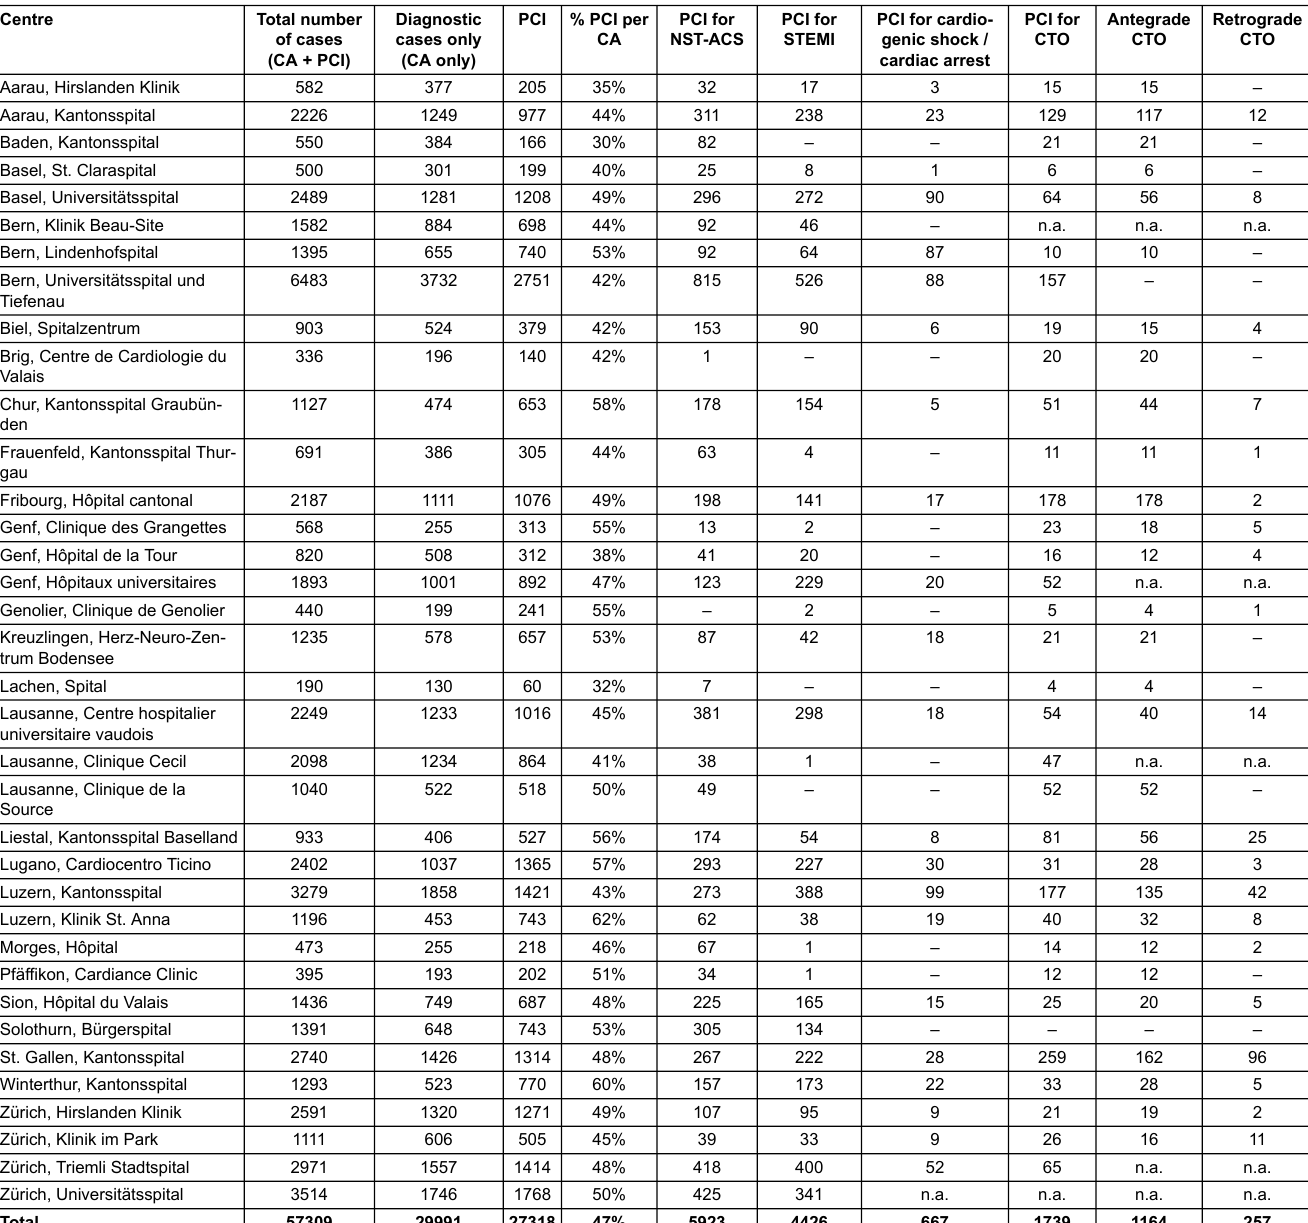
Table 2: Characteristics of the coronary interventions: number of cases and indications.